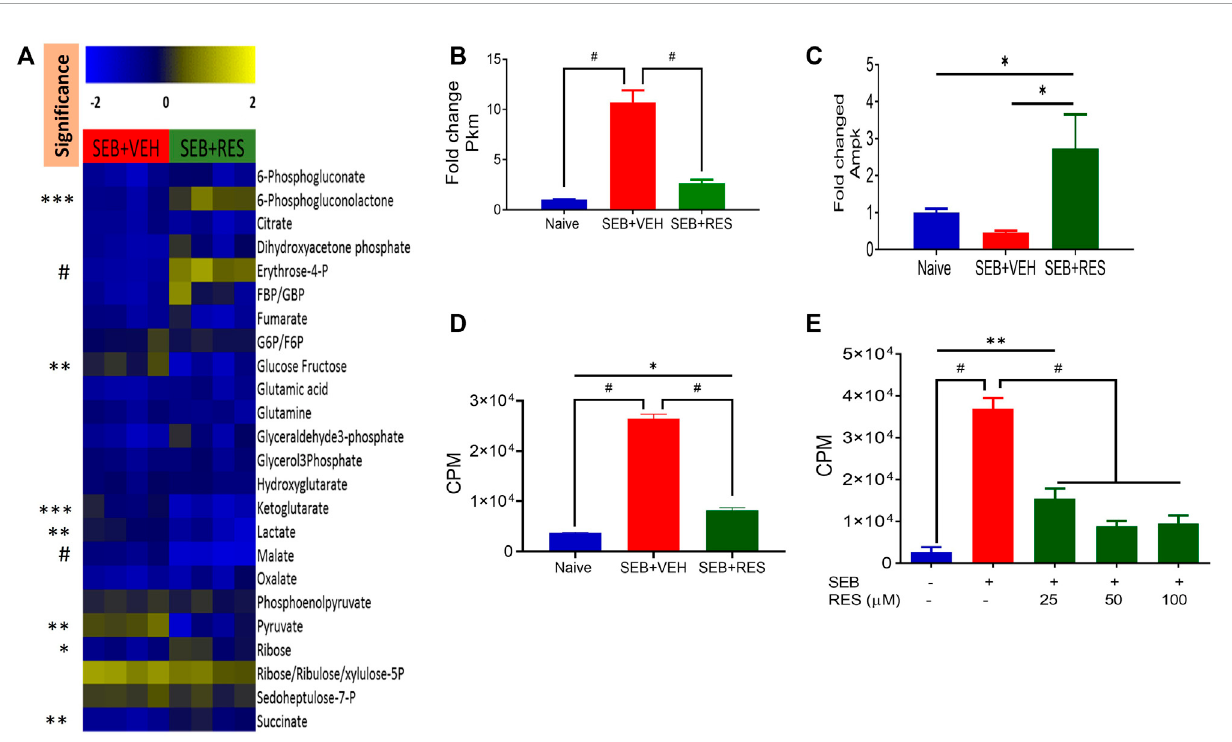
Resveratrol-mediated cell metabolism reprogramming leads to a reduction in the proliferative capacity of SEB-activated immune cells . Mice were treatedwithSEB+VEHorSEB+RESasdescribedinFigure1. (A) .LC-MSresultsshowingserummetabolomicpro fi le(n=4). (B) .Real-timeqPCRresultsof Pkm gene expression in the lung MNC. (C) . Real-time qPCR of Ampk gene expression in the lung MNC. (D) . Lung mononuclear cells were isolated by gradient separation from different study groups and then seeded in a 96-well plate and incubated with one μ Cui/well 3 H-thymidine for 16 h.